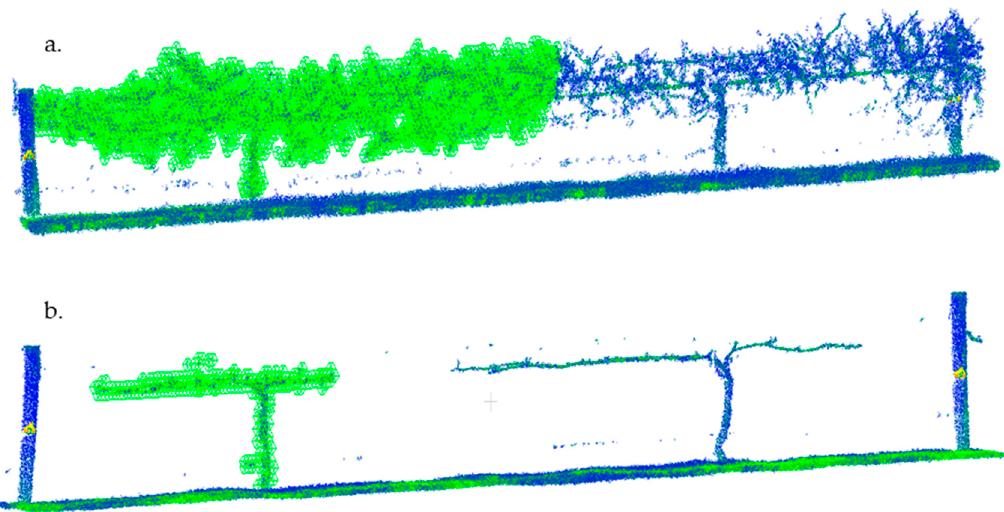
Figure 4. ( a , b ) This shows LiDAR scans made before (( a ), V Before (10) ) and after cane pruning (( b ), V After (10) ). Calculations of the voxel pruning volume (V Diff , Equation (1)) were made by subtracting the number of voxels (wire cubes) before ( a ) and after ( b ) pruning and comparing that value to the actual, physical pruning weight. The voxel number of post-pruned vines ( b ) was used to correlate LiDAR scans with trunk and cordon volume. Measurements of trunk volume were calculated using callipers as described in the methods. This image also illustrates what the octree algorithm looks like when applied to a point cloud. The left vine of the two-vine panel is voxelized.